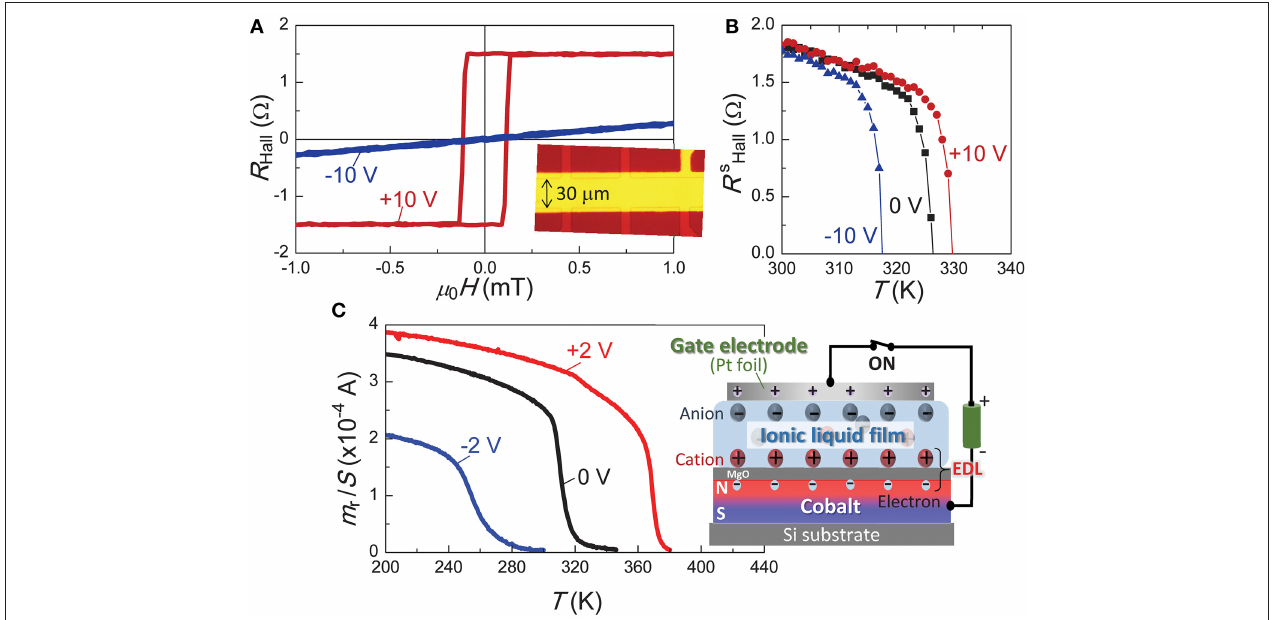
FIGURE 1 | Electric field effect on ferromagnetism in the Pt/Co system. (A) Magnetization curves detected in the Hall resistance R Hall for V G = − 10 and 10V at 321 K. The inset shows the top view of the Hall bar structure with the gate electrode on top (yellow region) taken by an optical microscope. Solid-state HfO 2 was used as a gate insulator in this device. (B) Temperature T dependence of the spontaneous Hall resistance R s Hall which is proportional to the spontaneous magnetization obtained with the device in (A) . The Curie temperature increases (decreases) with positive (negative) V G . (C) The T dependence of the remanent magnetic moment per unit area ( m r / S ) for V G = + 2 , 0, and − 2V. The inset shows the cross-sectional image of the device structure. An ionic liquid was used to gate the